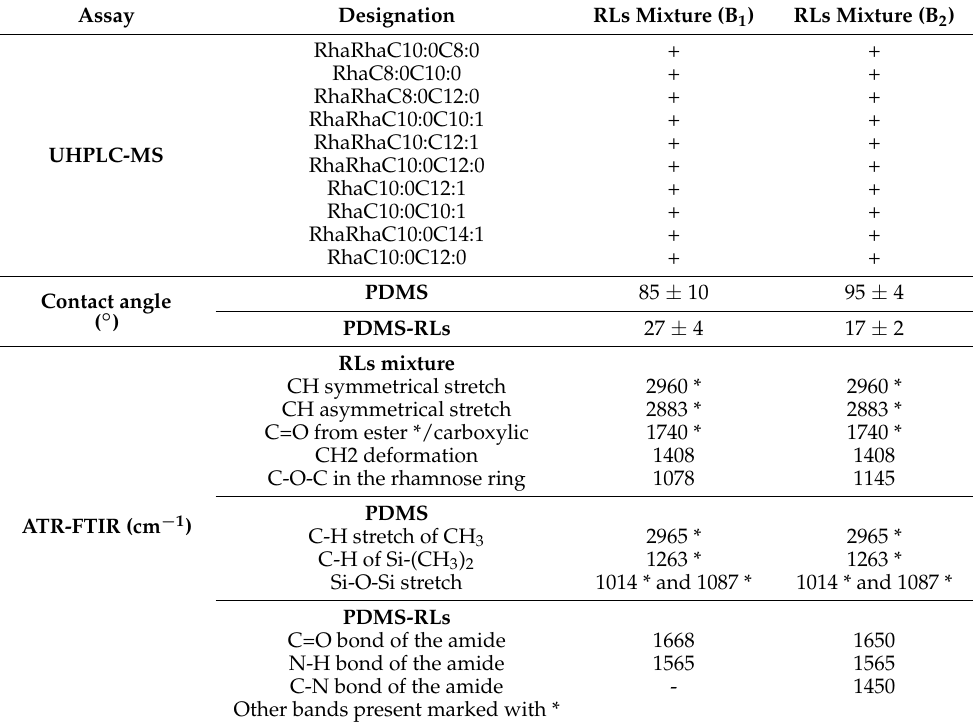
Table 1. Characterization of RLs mixture and functionalized PDMS surfaces used in this work and compared with a previous publication [13]. RLs mixture used in the present and previous work were obtained from 2 different batches (Sigma Aldrich), designated here as B 1 and B 2, respectively. RLs Mixture (B2) data was adapted from